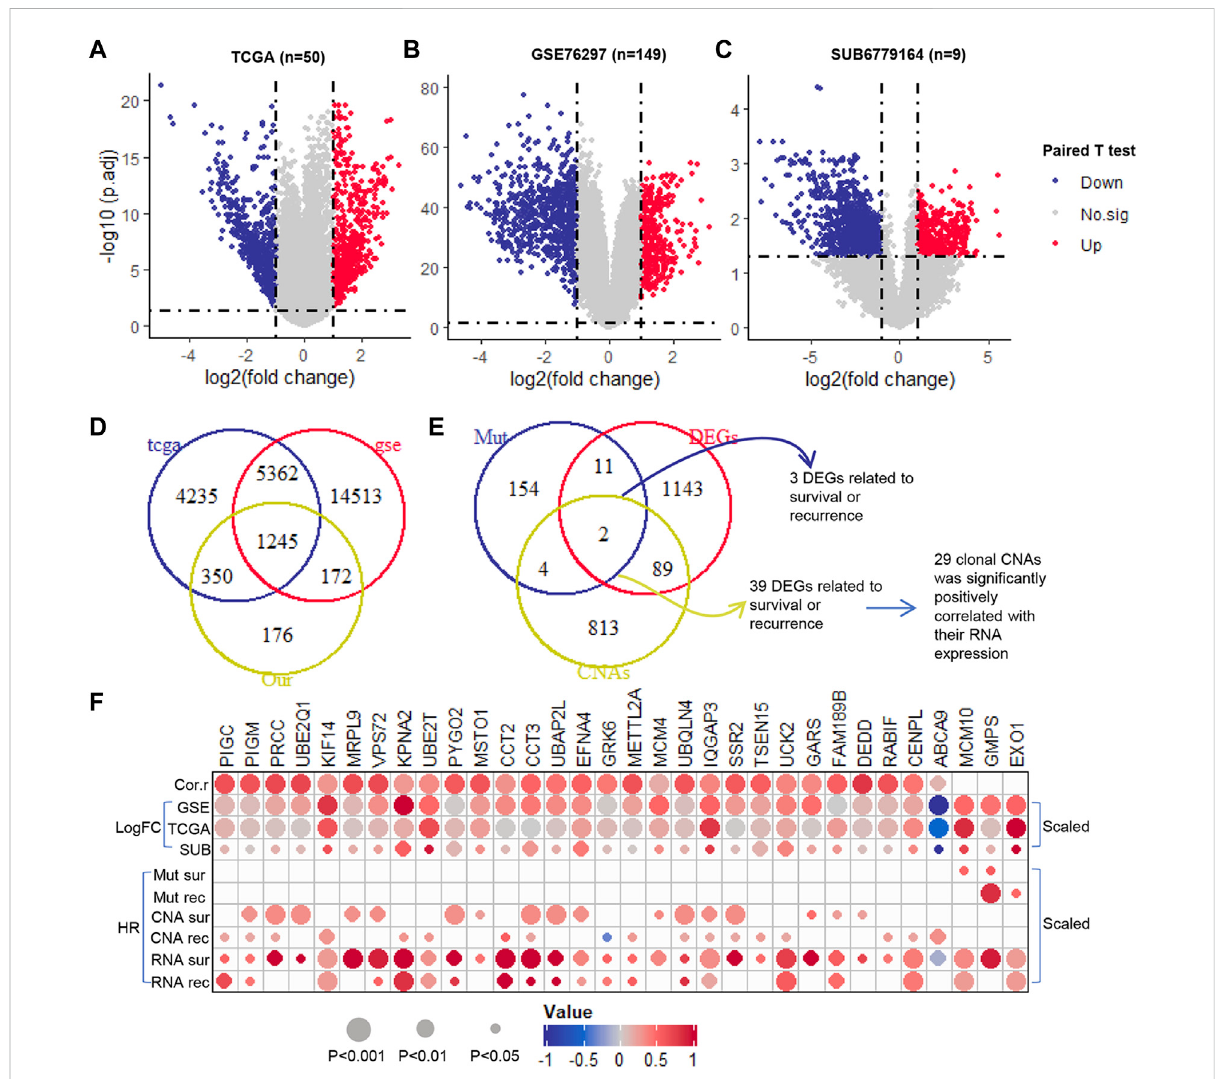
FIGURE 3 The prognosis potential of clonal altered genes in RNA level. (A – C) . The Volcano plot of DEGs in TCGA (50 paired tumor and normal samples), GSE76297 (149 paired tumor and normal samples), and SUB6779164 (9 paired tumor and normal samples) (D) . The Venn diagram of DEGs in TCGA, GSE76297,and SUB6779164 (E) .TheVenndiagramoftheselectedDEGs, prognosis-relatedclonal somaticmutations, andCNAs (F) .Thecorrelation between the genomic and transcriptomic levels of the candidate genes. Down, down-regulation; Up, up-regulation; No.sig, no signi fi cant difference; DEGs, differentially expressed genes; Cor.r, the correlation between the GISTIC score and RNA expression of the candidate clonal CNAs. LogFC, log2 (fold change) (which was scaled from − 1 to 1); HR, hazard ratio (which was scaled from − 1 to